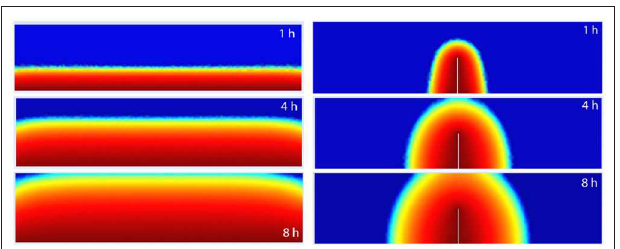
FIGURE 5 | 2D time dependent water content distributions of cases (a and c) of Figure 2 , respectively.